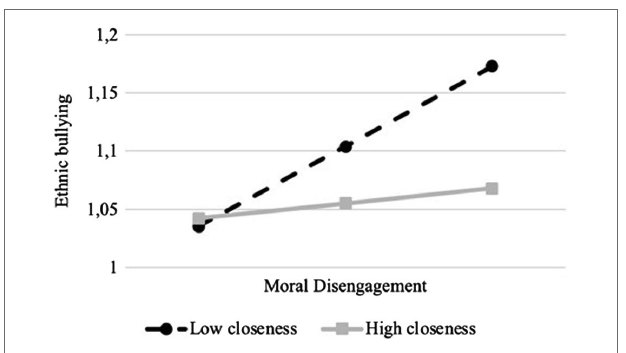
TABLE 2 | Unstandardized regression coefficients of moral disengagement and ethnic prejudice on ethnic bullying, and the moderating effect of closeness with the teacher.